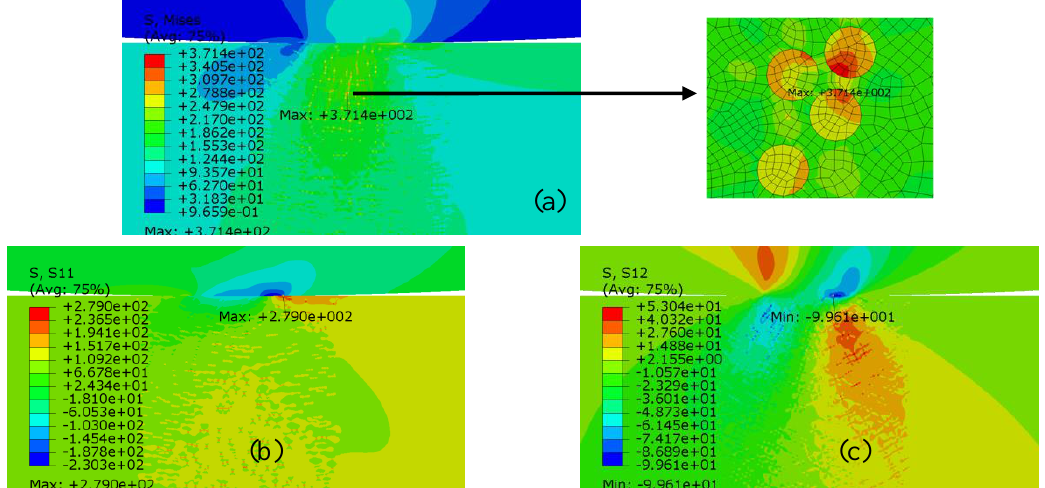
Figure 15. Stress distribution of Case 5 below the contact surface, ( a ) Mises stress, ( b ) tensile stress, and ( c ) shear stress.